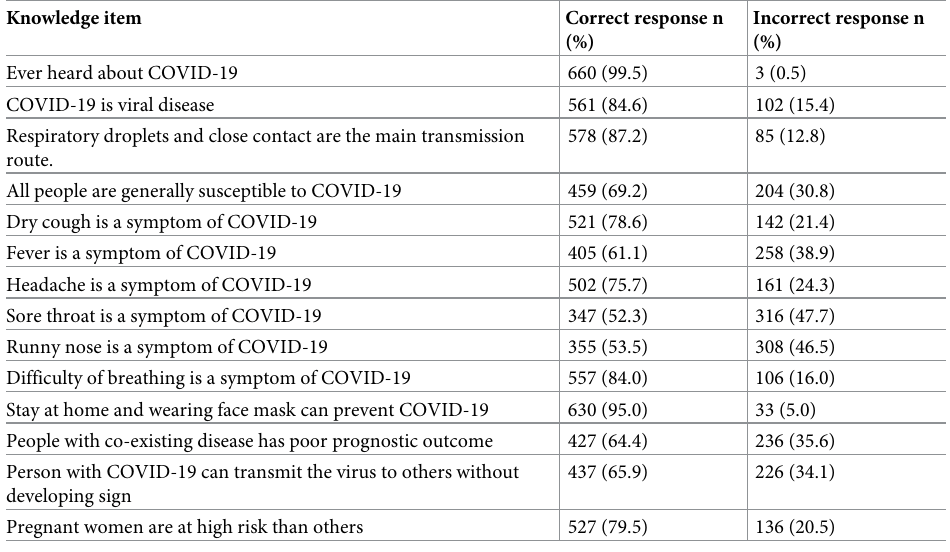
Table 3. Knowledge of pregnant women about COVID-19 in Gondar city, northwest Ethiopia 2021 (n = 663).